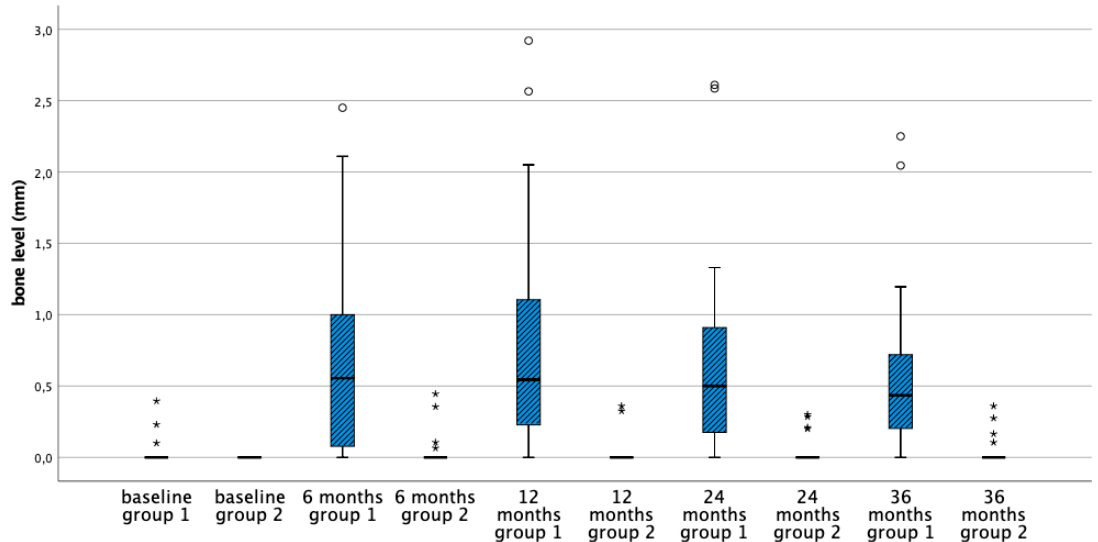
Figure 3. Boxplots representing the bone level at subsequent time points for the equicrestally (group 1) and subcrestally placed implants (group 2). * Outliers ( ≥ 3 × IQR above third quartile), ° suspected outliers (between 1.5 × IQR and 3 × IQR above third quartile).